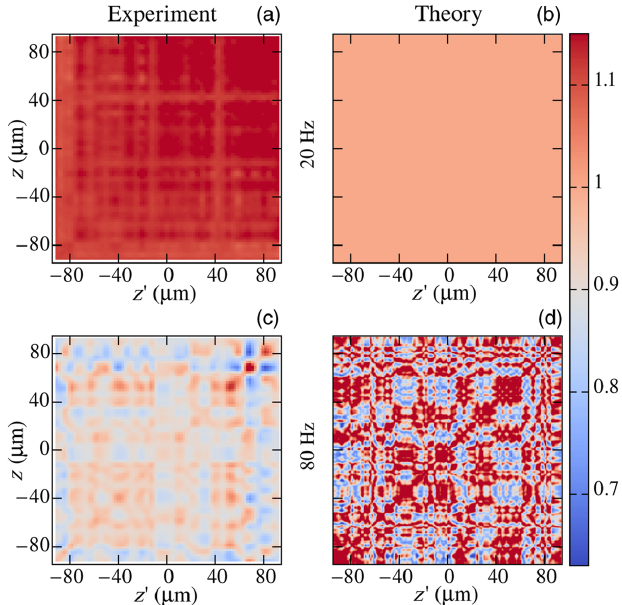
FIG. 8. Second-order correlation functions. (a) Correlation function C ð 2 Þ ð z; z 0 Þ calculated from the experimental data for ω ¼ ð 2 π Þ 20 Hz. (b) Correlation function g ð 2 Þ ð z; z 0 Þ calculated from the MB theory for the same parameters as (a). (c) C ð 2 Þ ð z; z 0 Þ calculated from the experimental data for ω ¼ ð 2 π Þ 80 Hz.